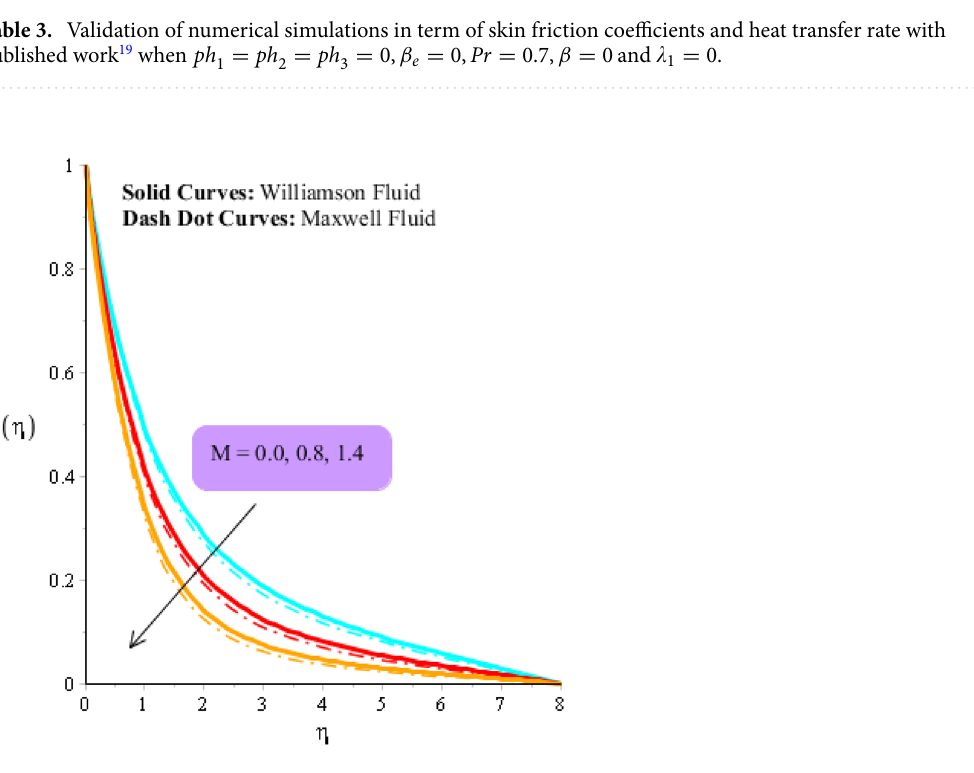
Figure 3. Influence of M versus secondary velocity